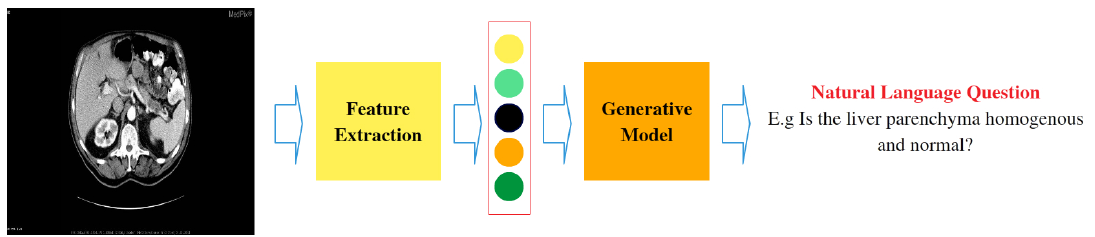
Figure 1. The VQG pipeline: image is taken as input to generate the